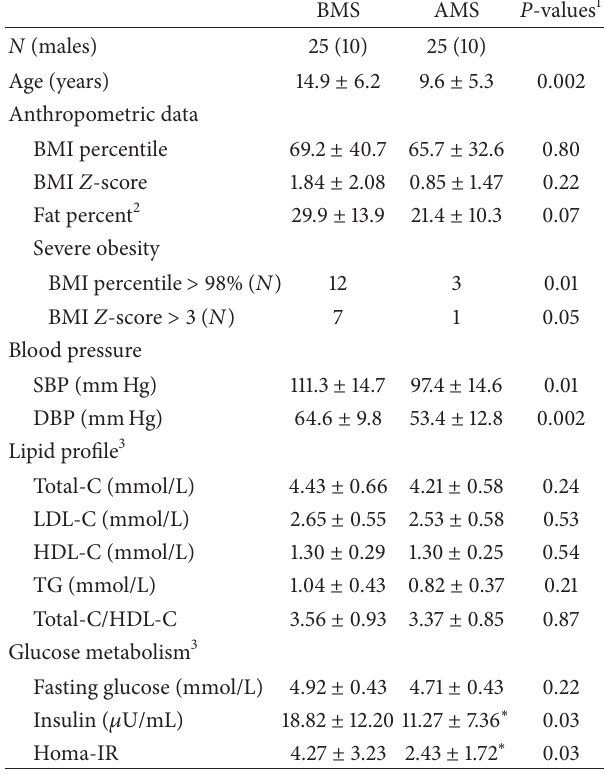
Table 1: Offspring